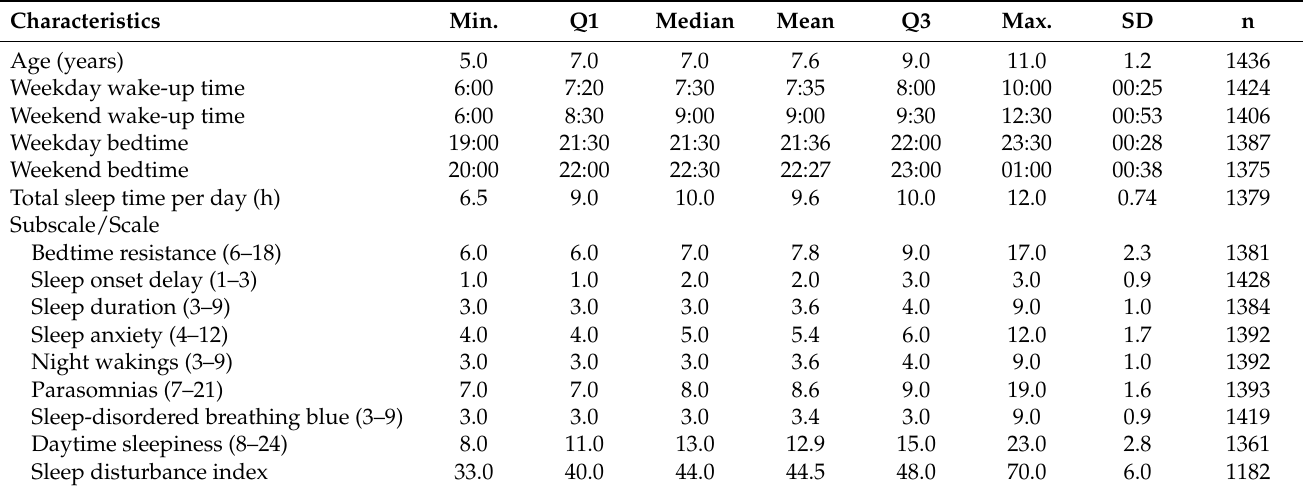
Table 2. Age and sleep habits of the children and scores of the CSHQ-PT (Min. = minimum, Q1 = first quartile, Q3 = third quartile, Max. = maximum, SD = standard deviation, n = number of valid observations). For each subscale of the CHSQ, the numbers in parenthesis are the possible minimum and maximum